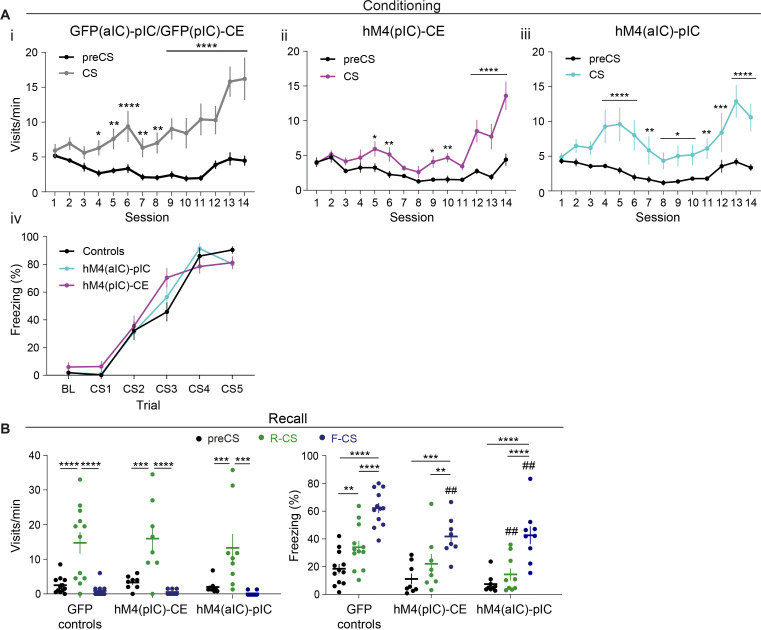
Valence-specific conditioned responses of chemogenetic pIC–CE and aIC–pIC manipulation cohorts.(A) Learning curves of the aIC–pIC and pIC–CE cohorts for approach behavior of the (i) control (significant CS x session interaction in a two-way RM ANOVA, F13,130=5.97, p<0.0001), (ii) hM4(pIC)-CE (significant CS x session interaction in a two-way RM ANOVA, F13,91=9.07, p<0.0001) and (iii) hM4(aIC)-pIC groups (significant CS x session interaction in a two-way RM ANOVA, F13,104=3.30, p=0.0003). (iv) Learning curves of avoidance behavior of control and treatment groups during the FC stage (significant effect of trial in a two-way RM ANOVA, F5,125=174.70, p<0.0001). (B) (i) Quantification of CS-specific (left) approach (significant effect of CS in a two-way RM ANOVA, F2,36=31.88, p<0.0001) and (right) avoidance behavior (significant effect of treatment in a two-way RM ANOVA, F1,18=8.65, p=0.0087) at drug-free recall in mice that underwent chemogenetic pIC–CE inhibition during conditioning. nGFP = 12 nhM4(pIC–CE)=8. (ii) Quantification of CS-specific (left) approach (significant effect of CS in a two-way RM ANOVA, F2,38=30.32, p<0.0001) and (right) avoidance behavior (significant effect of treatment in a two-way RM ANOVA, F1,19=15.80, p=0.0008) at drug-free recall in mice that underwent chemogenetic aIC–pIC inhibition during conditioning. nControls = 12, nhM4(aIC)-pIC=9. Note that the control group was shared between the hM4(pIC)-CE and hM4(aIC)-pIC cohorts, as they were trained in parallel. Holm-Sidak post hoc was used for all analyses. */#/$p<0.05, **/##p<0.01, ***p<0.001, ****p<0.0001, where ‘#’ indicates comparison to the control group. All data presented as mean ± SEM. Full statistical report in Appendix 1—table 1.